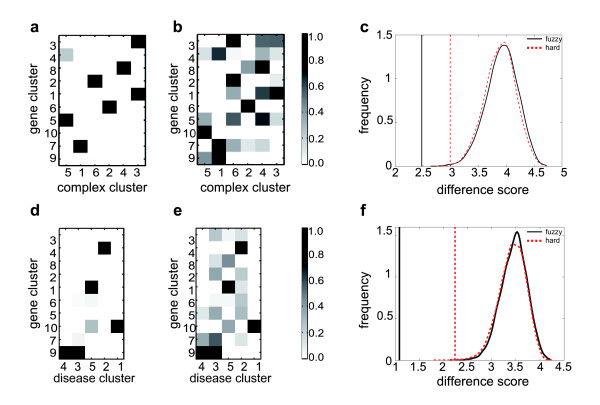
Evaluation of the backbone of the gene-disease-protein complex network. To evaluate the large-scale clustering we additionally included functional annotations. (a) and (b) compare the gene-complex backbone graph with the functional correlations of the extracted clusters according to FunCat annotation. Similarly, (d) and (e) show the gene-disease backbone and the clusters' disorder class correlations (see Methods). We see that interconnected clusters also seem to correlate in their annotations. To test this hypothesis rigorously, we calculated difference scores as defined in Methods in order to quantify the correlation of the backbones and their annotations, respectively. Vertical lines in (c) and (f) correspond to these difference scores for the fuzzy (black) and the hard (red) clustering. Comparing these values to the difference scores for 105 randomized cluster assignments we obtain significant p-values, both < 10-5. The correlations between annotations of connected clusters of the backbone is higher when applying the fuzzy approach.